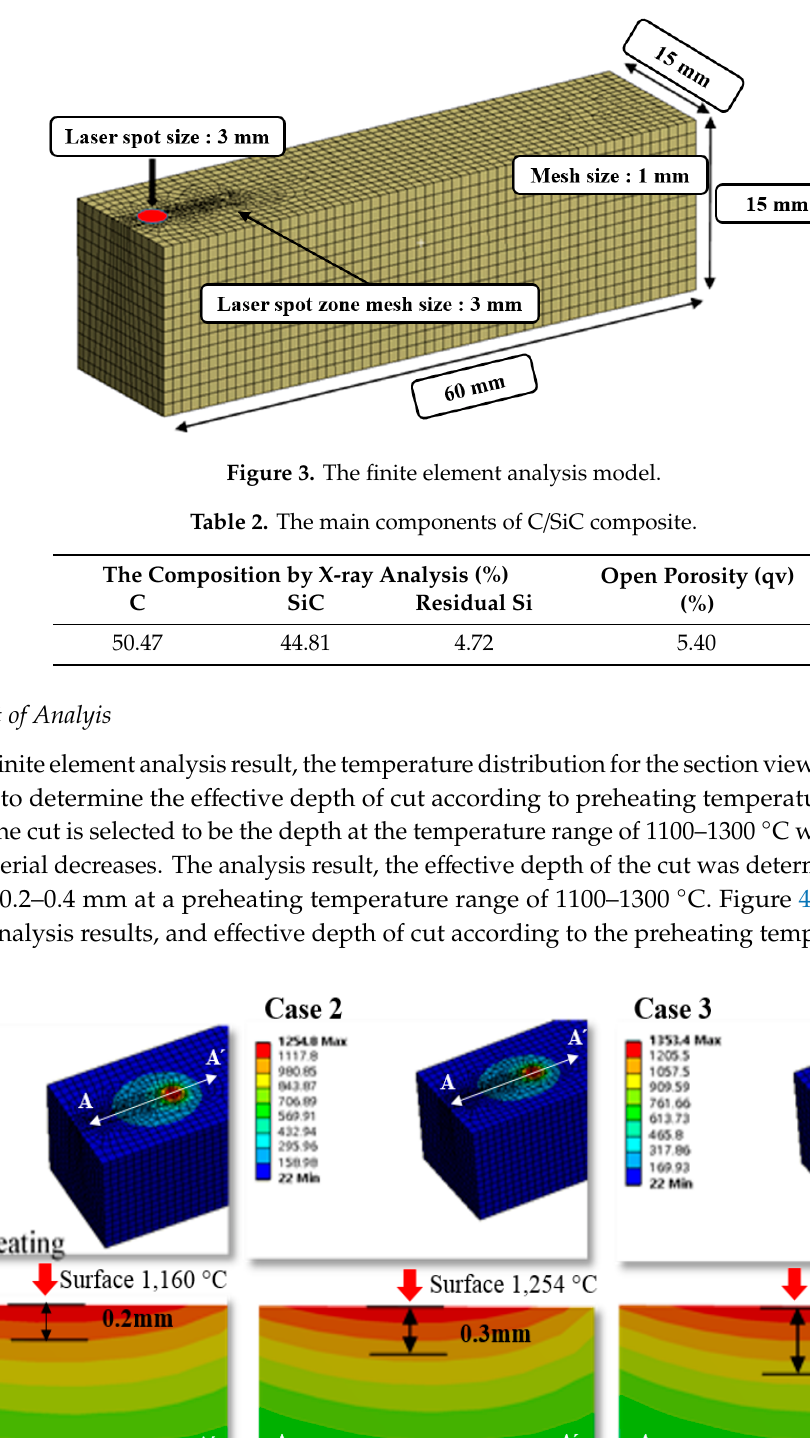
Figure 2. The tensile stress value according to temperature of C/SiC composite.